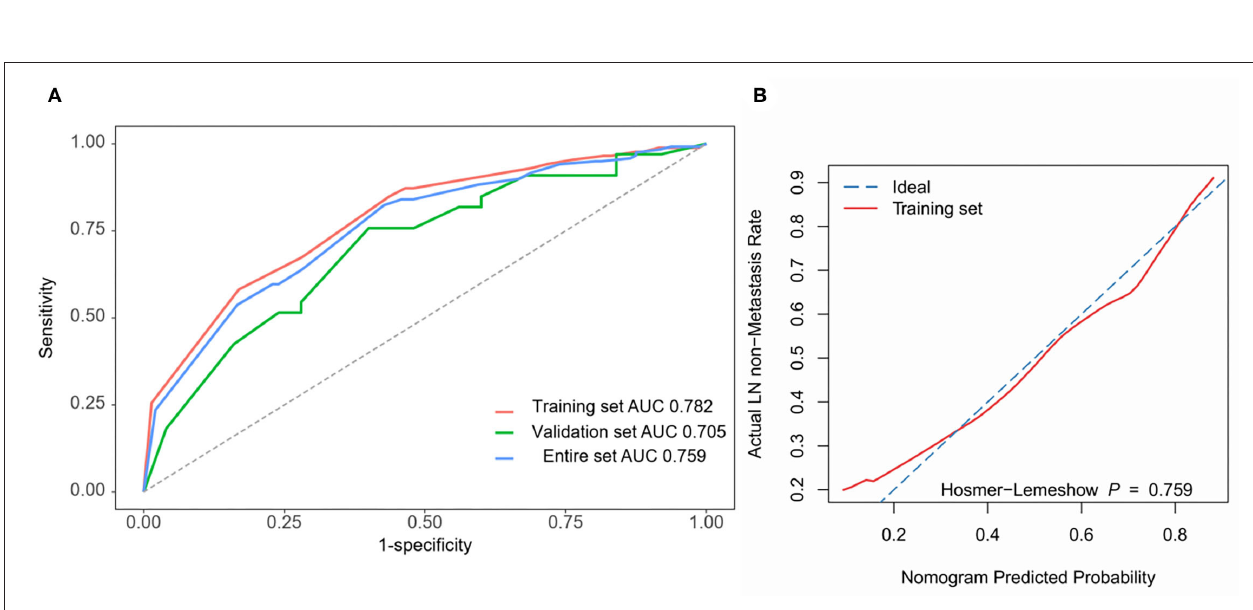
Frontiers in Surgery |